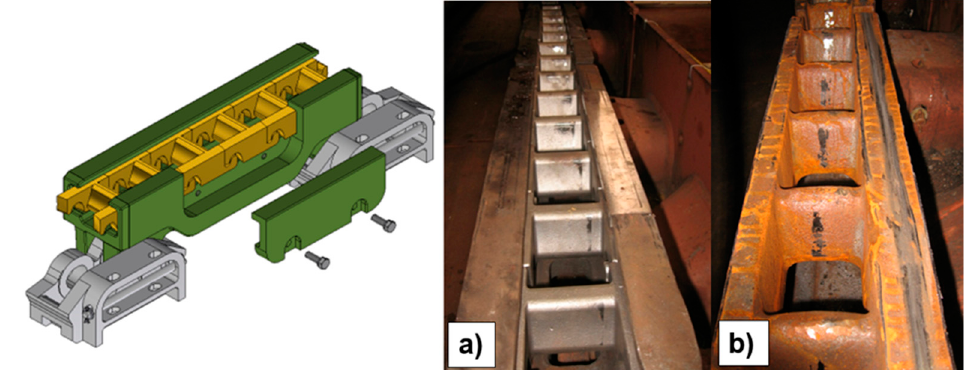
Figure 3. Model of the Flextrack haulage system with a layout of toothed elements in the guide and a comparison of elements collaborating with the track wheel: ( a ) Flextrack haulage system, ( b ) Eicotrack haulage system.